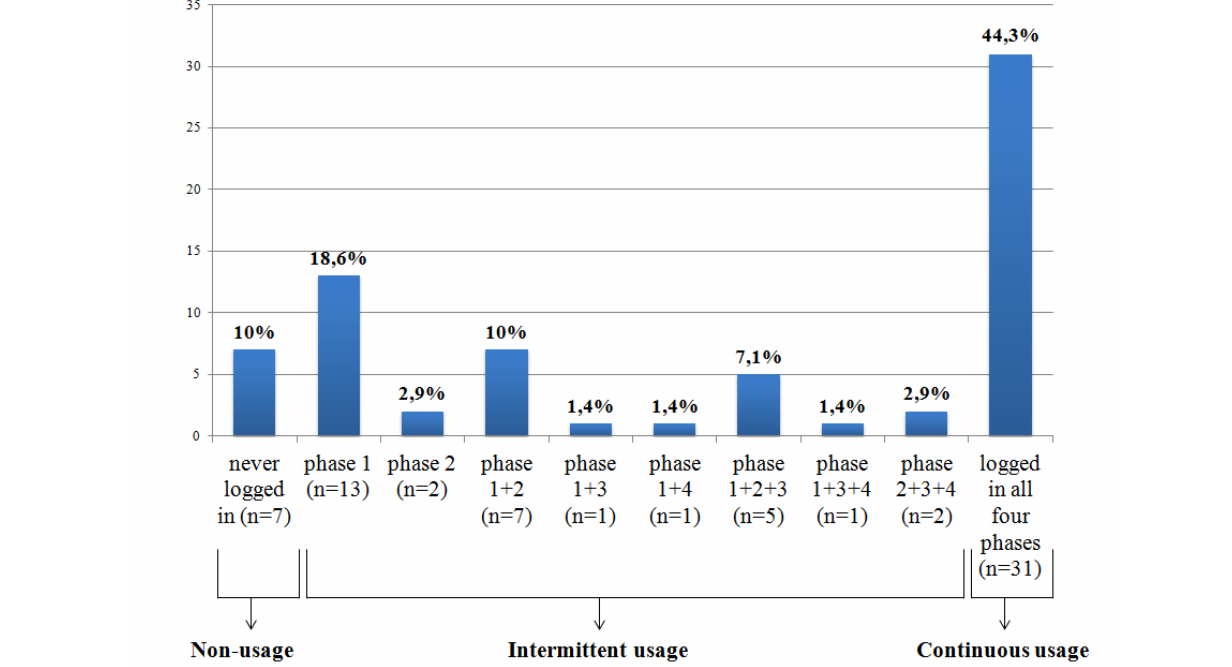
Figure 1. Continuous usage and intermittent usage based on logins during 4 intervention phases